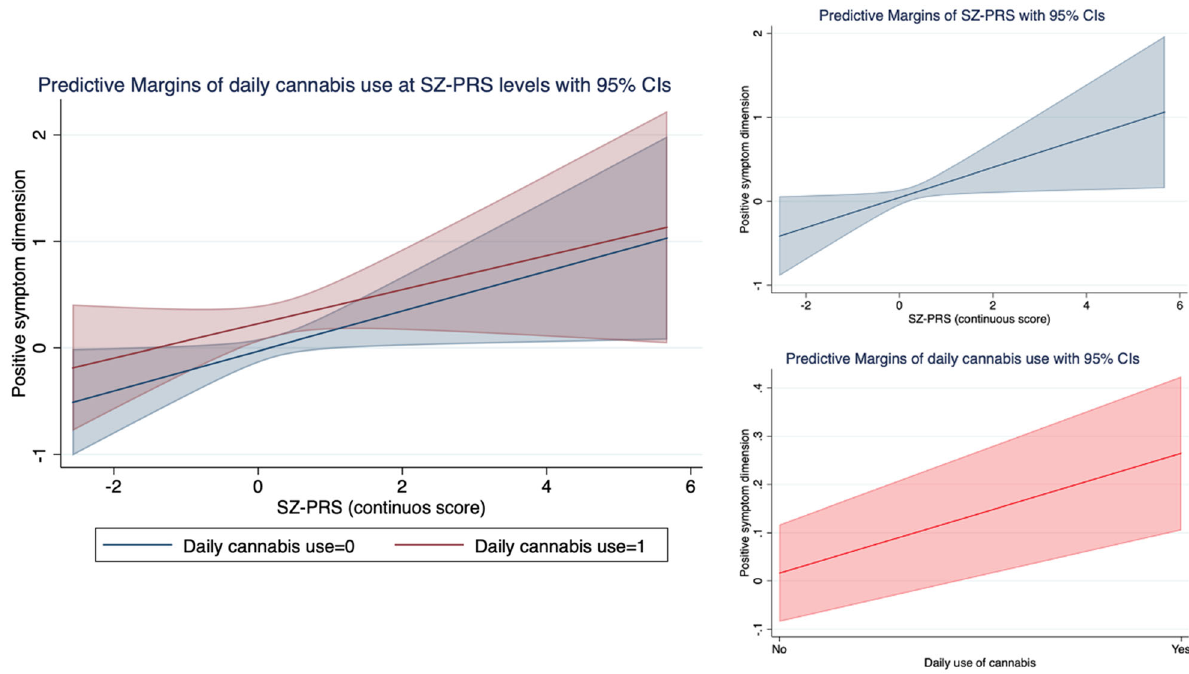
Fig. 2 Positive symptom dimension by SZ-PRS and cannabis use in FEP patients. The graph on the left illustrates the independent and joint effect of daily cannabis use (blue line: no; red line: yes) and SZ-PRS (x axys) on the positive symptom dimension (y axys). The two graphs on the right present the main effect of SZ-PRS (in blue, x axys) and daily cannabis use (in red, x axys) on the positive symptom dimension (y axys). Values are adjusted for age, sex, and 10 ancestry